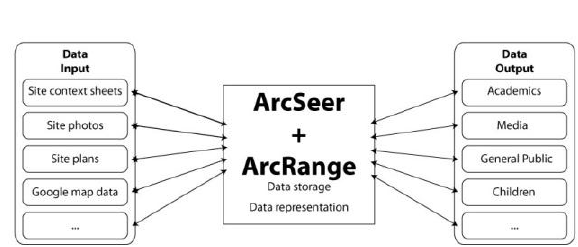
Figure 1: The ArcSeer/ArcRange knowledge